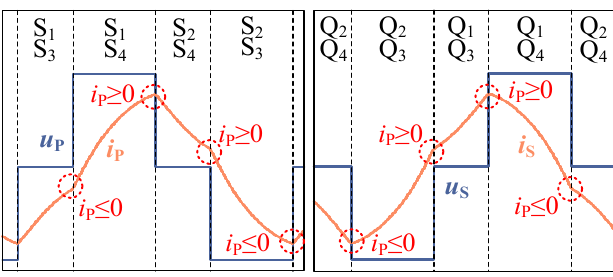
Figure 8. Main voltage and current waveforms of soft ‐ switching.